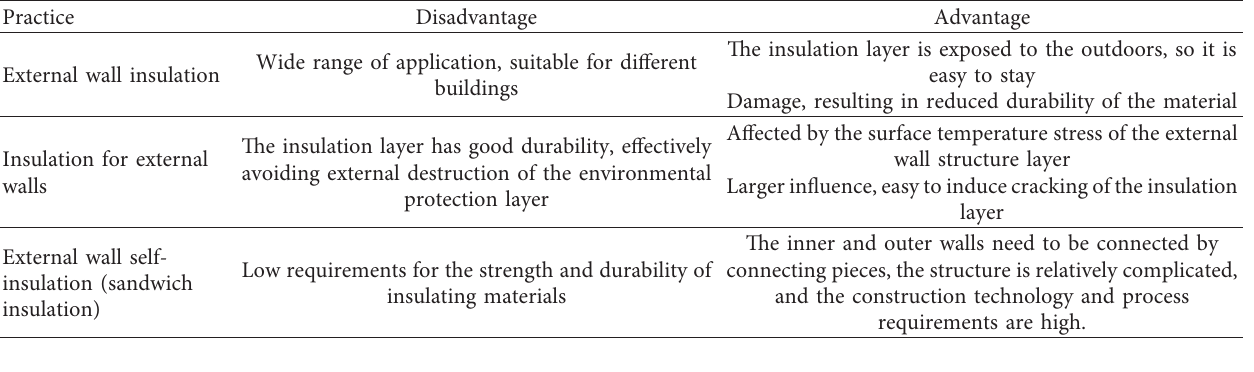
Table 4: External wall insulation technology.